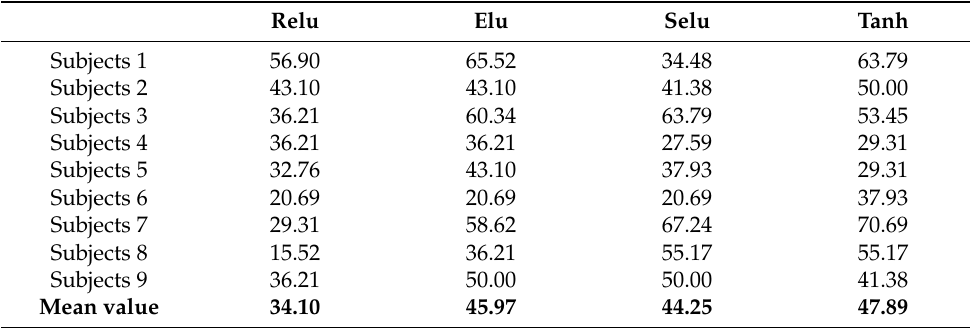
Table 5. Classification accuracy of the proposed merged CNNs methods (%).